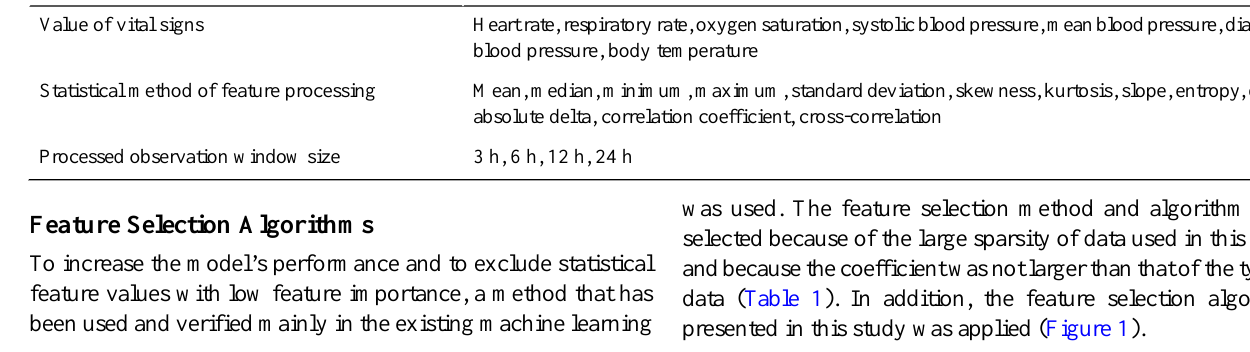
Table 1. Experimental settings of the vital signs, statistical methods, and processed window time. h: hours. Experimental